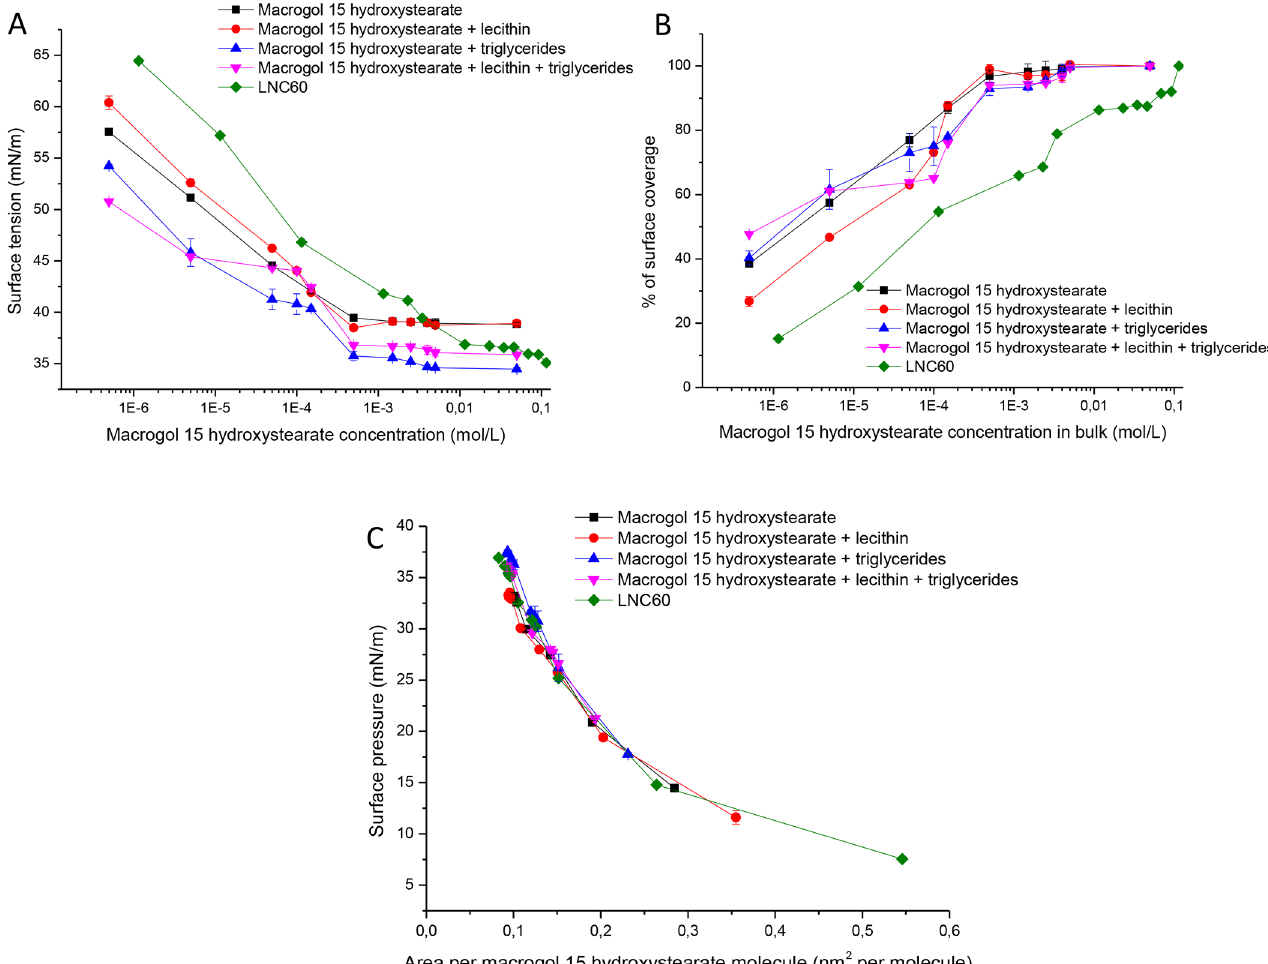
Fig 3. Surface tension as a function of the MHS concentration (A)surface coveragepercentage as a function of MHS concentration, (B) surface pressure versus area per MHS moleculeand (C) the MHS solution,LNC dispersion and binary and ternary mixtures of LNC componentsas determinedby the Wilhelmy plate